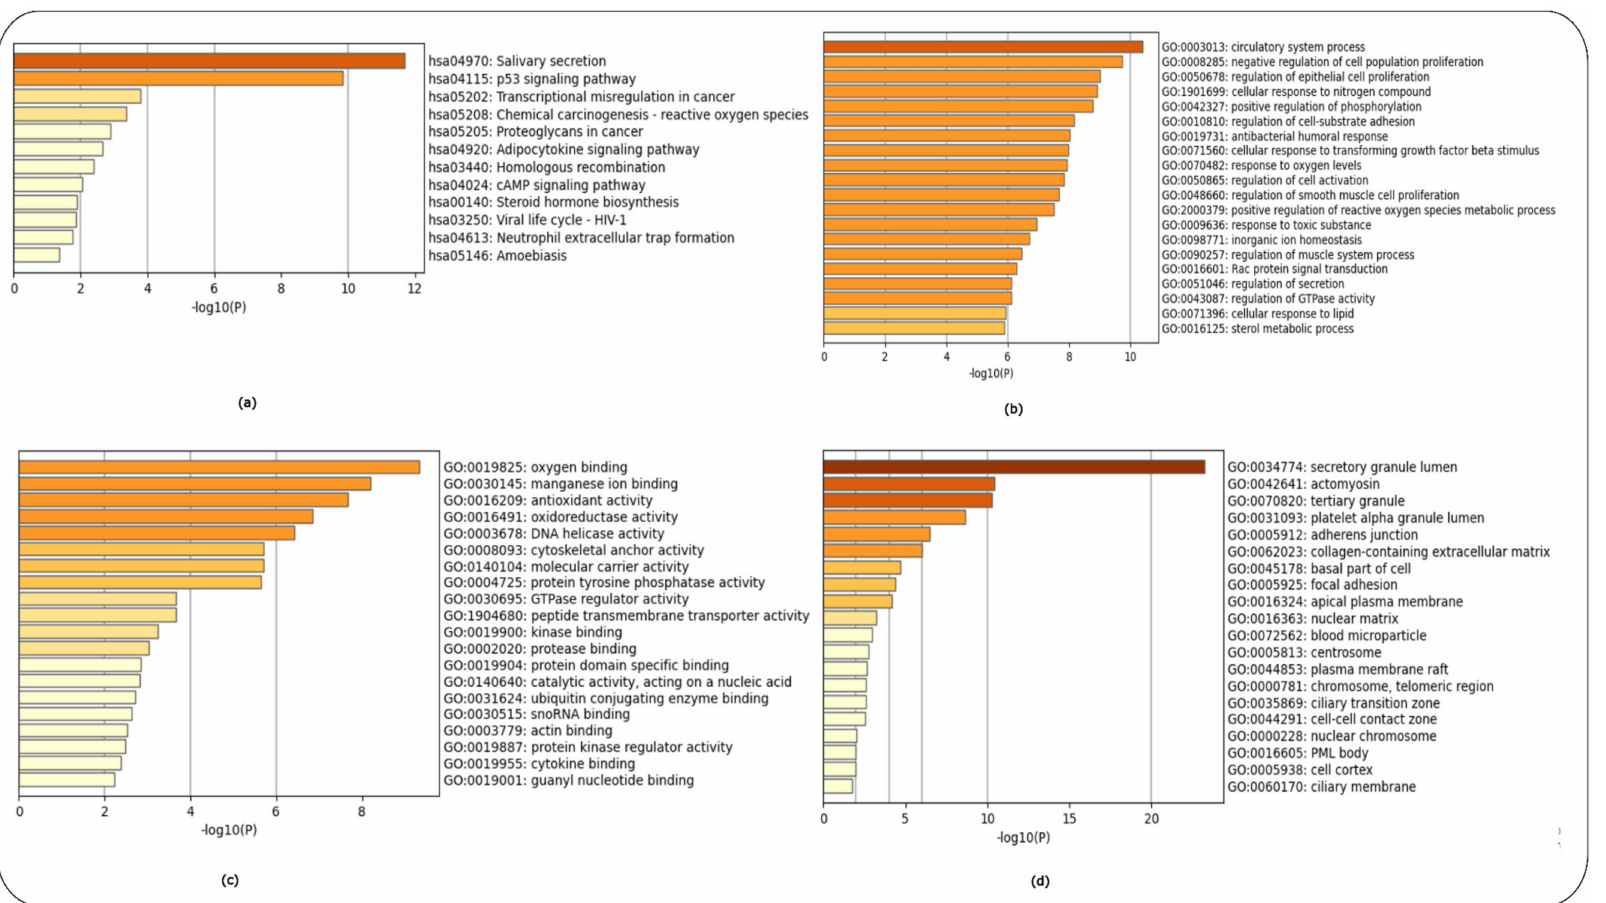
Figure 7. Enrichment analysis of controls versus Stage 2 HD patients (Year 3) using the KEGG and GO libraries in Metascape. ( a ) KEGG pathways, ( b ) GO Biological Process, ( c ) GO Molecular Function and ( d ) GO Cellular